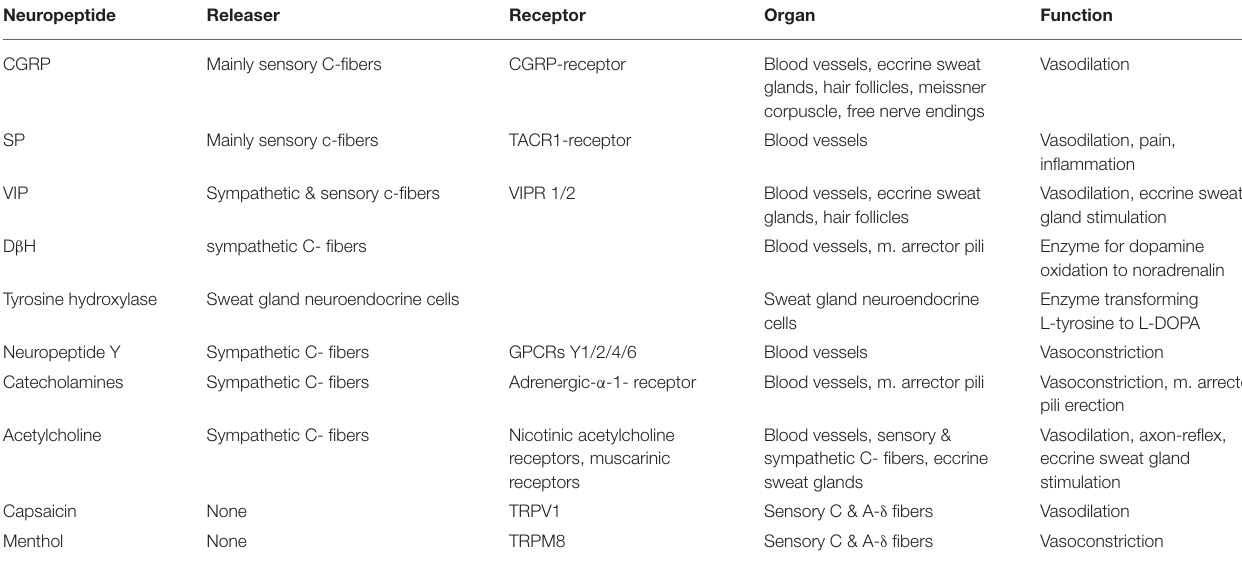
Table of neuropeptides relevant to function and structure of small nerve fibers, highlighting their effects on the effector organs. CGRP, Calcitonin Gene Related Peptide; SP, Substance P; VIP, Vasoactive Intestinal Peptide; D β H, Dopamine beta Hydroxylase; TACR1, Tachykinin Receptor 1; VIPR ½ , Vasoactive Intestinal Peptide Receptor 1/2; GPCR, G Protein Coupled